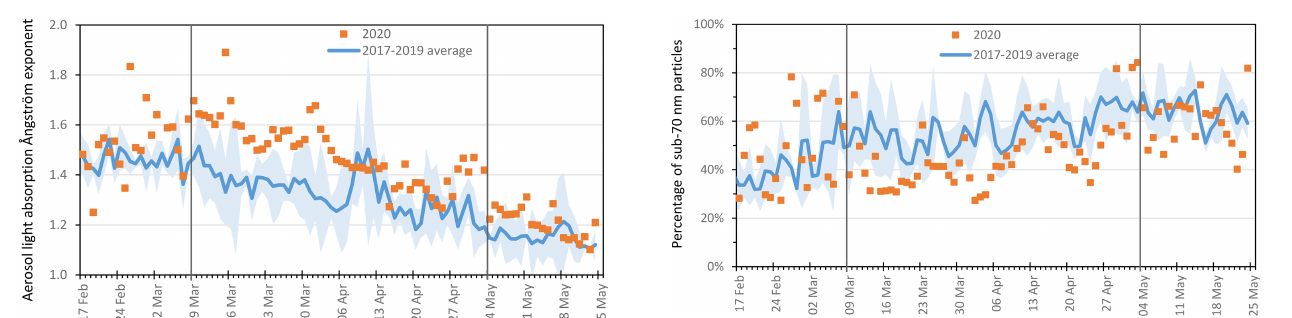
Figure 5. Aerosol light absorption Ångström exponent (AÅE) in 2020 (dots) compared to its 2017–2019 average (lines). The shaded area represents ± 1 standard deviation of the average. Vertical lines indicate the beginning and the end of the lockdown period.